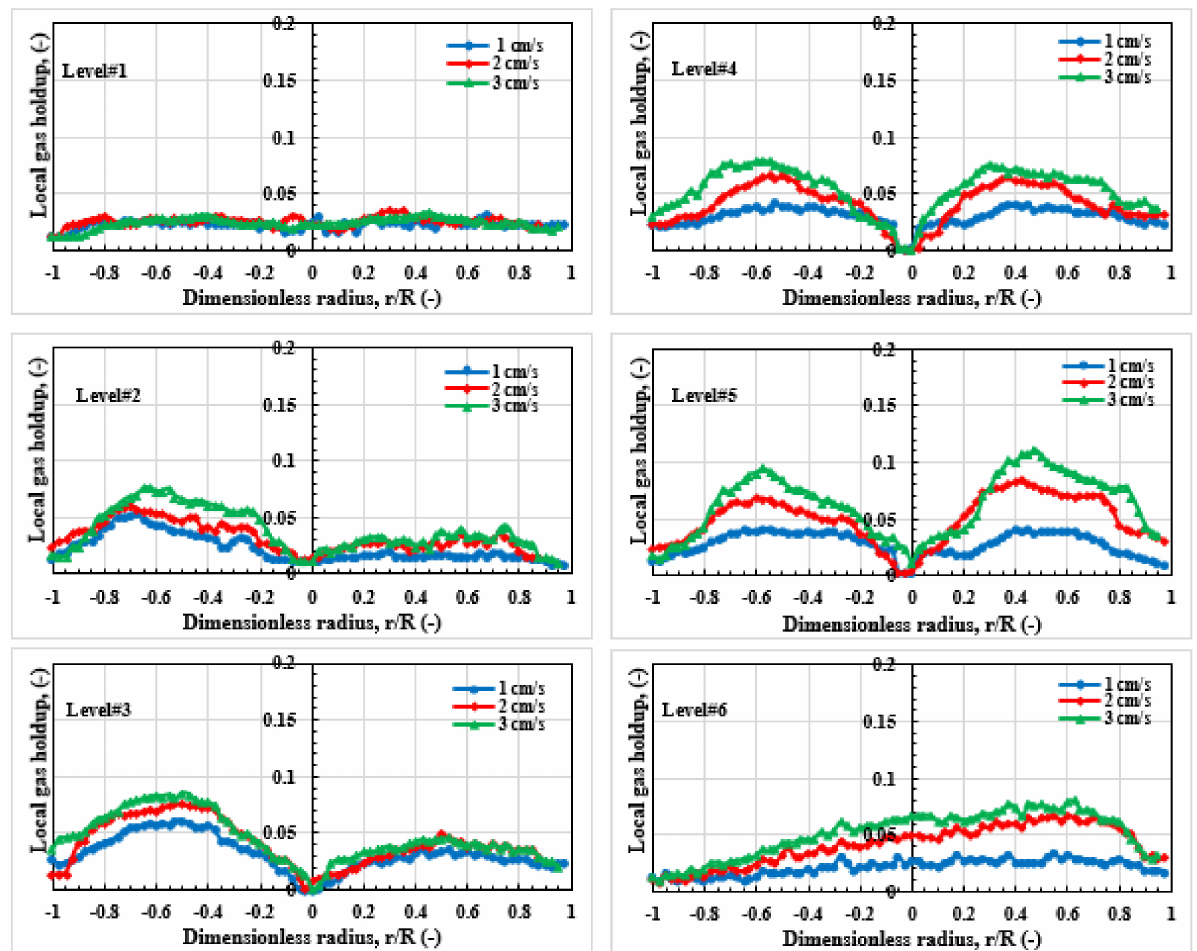
Figure 11. Local gas holdup profiles at different height of split airlift reactor operated under different gas